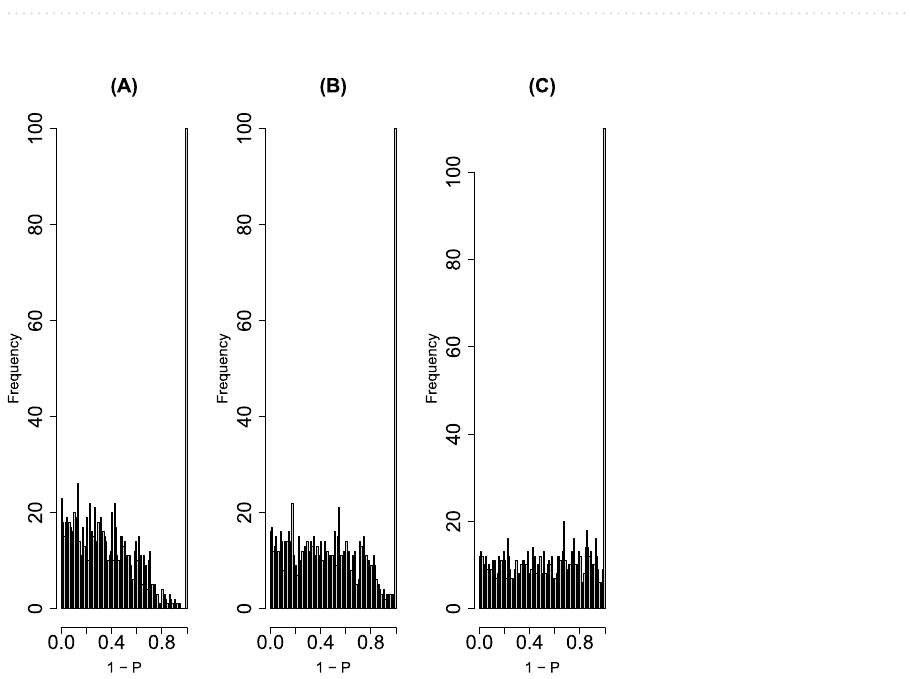
Table 1. Confusion matrix of the Gaussian distribution with outliers and prediction for x i , the historam for which is given in Fig. 4.